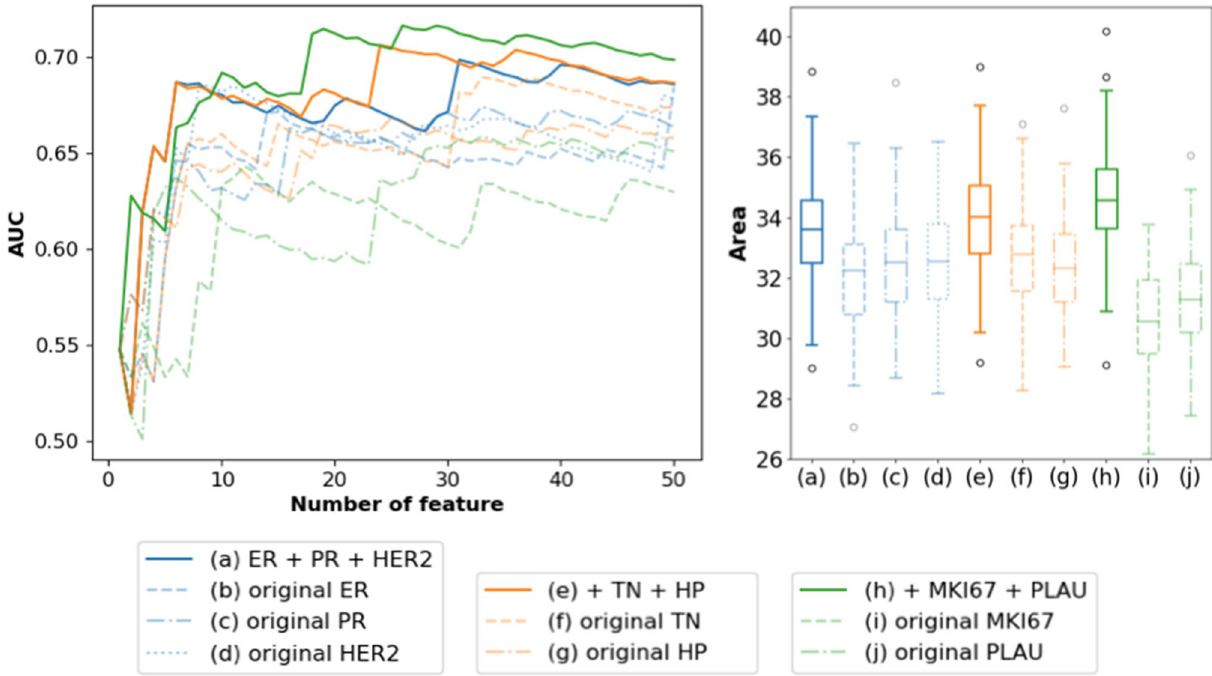
Figure 3. Aggregating a different number of functions in function perturbation. ( a ) Aggregating ER, PR, and HER2-selector. ( b – d ) Original feature selection result of ER, PR, and HER2-selector. ( e ) Further aggregating TN and HP. ( f – g ) Original feature selection result of TN and HP-selector. ( h ) Further aggregating MKI67 and PLAU. ( i – j ) Original feature selection result of MKI67 and